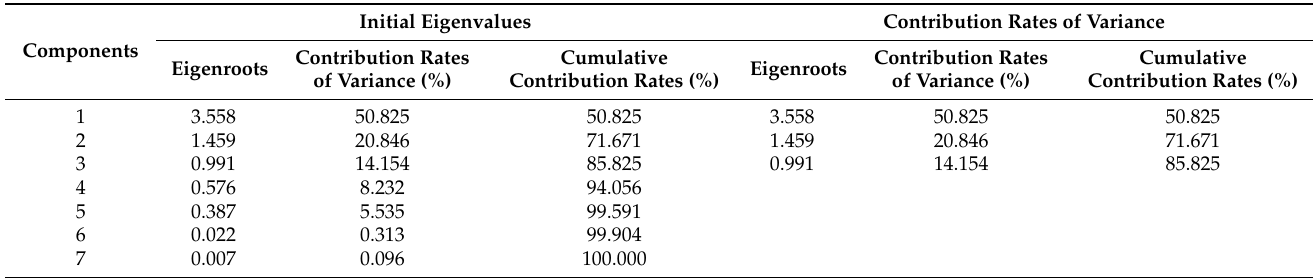
Table 5. Cumulative contribution rates of variance of eye movement indicators.